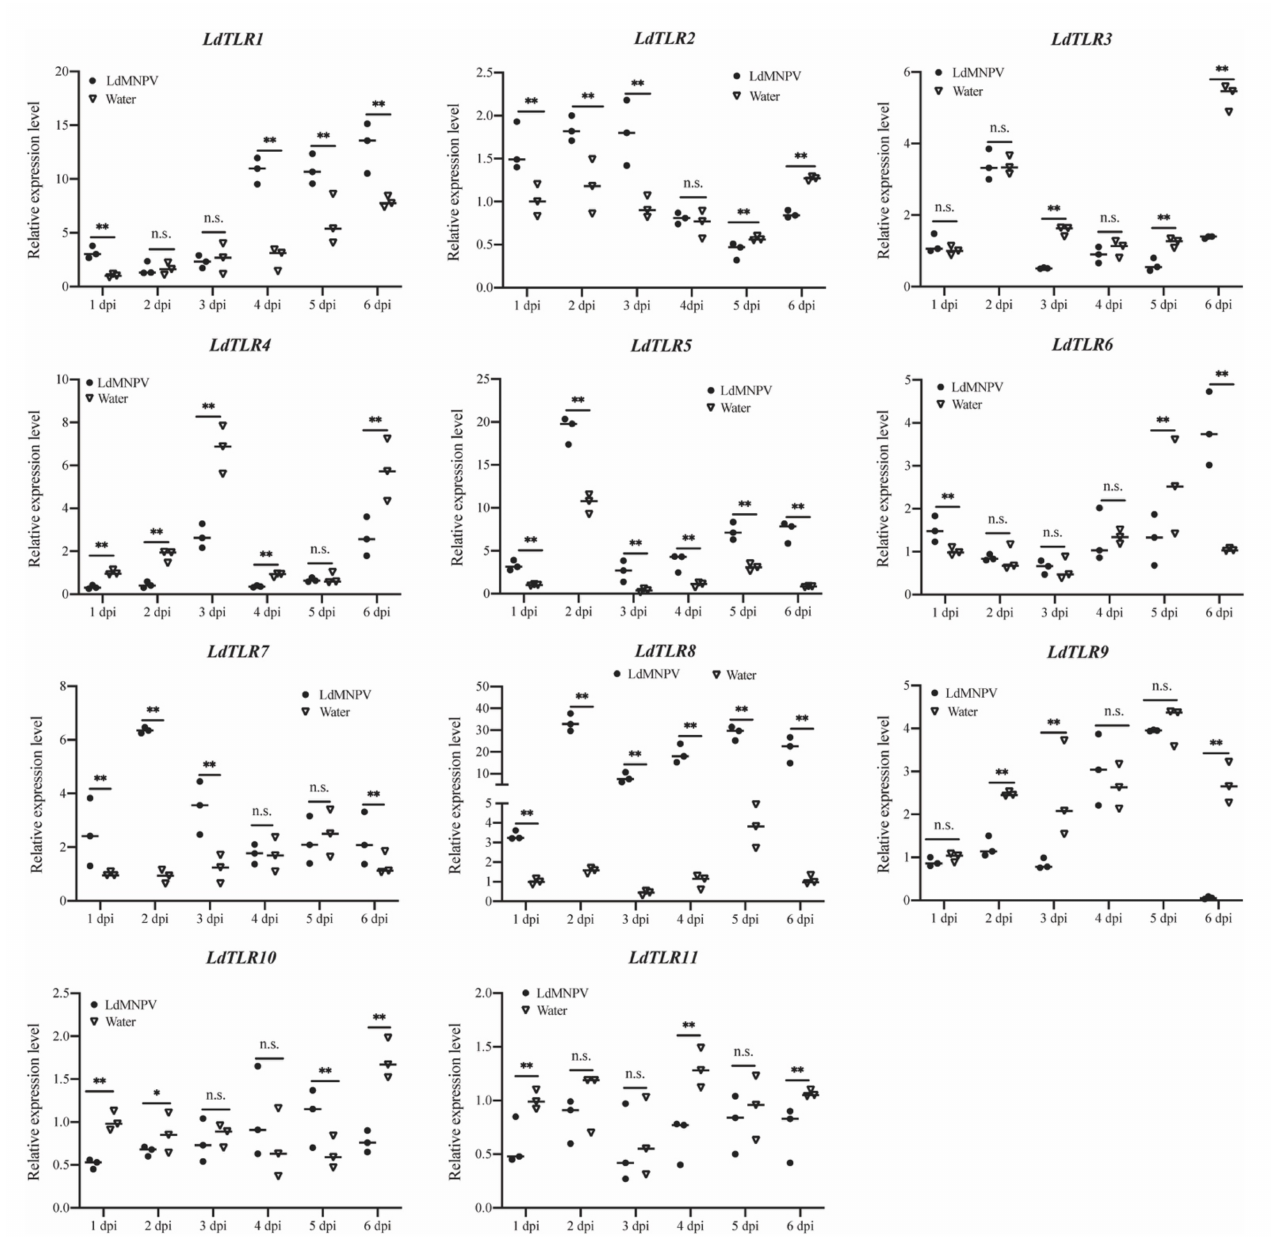
Figure 5. Relative mRNA expression levels of L. dispar Toll-like receptors upon LdMNPV infection. The horizontal line represents the median. Statistically significant differences are indicated with * ( p < 0.05) and ** ( p <